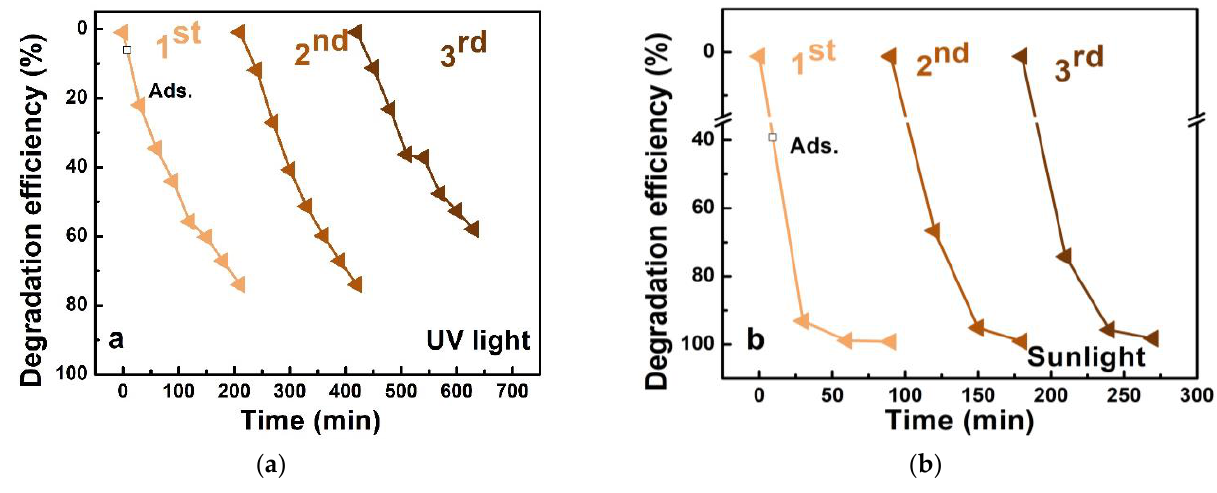
Figure 6. Repeatability tests for ( a ) TiO 2 /3D-GF/Ni, 1 cm 2 under UV 365 nm irradiance, and ( b ) TiO 2 /3D-GF/Ni 4 cm 2 under solar irradiance. The duration of illumination in each cycle was to the decolorization, that is 210 min in the case of UV light and 90 min in the case of sunlight. As presented in Table 1, the efficiency of the tested TiO 2 /3D-GF/Ni